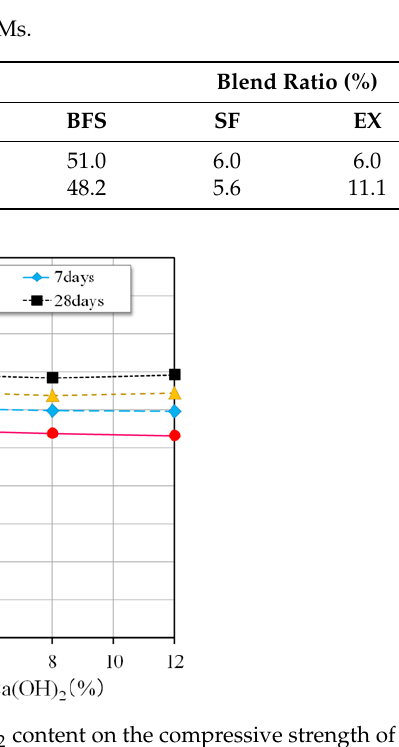
Figure 3. Effect of Ca(OH) 2 content on the compressive strength of IBPM mortar.